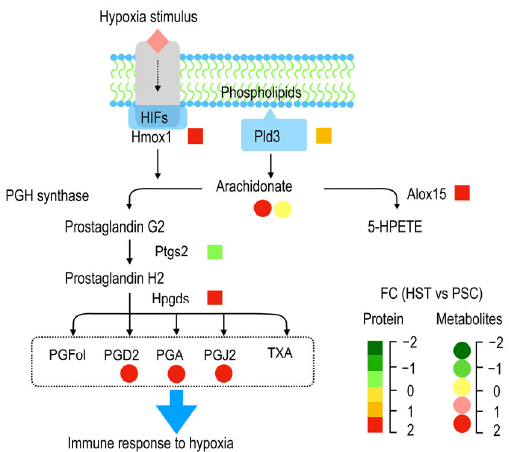
Figure 5. Schematic representation of the changes in metabolites and proteins involved in arachi ‐ donate acid metabolism during hypoxia response in spleen of mice. Names of PGFol, PGD2, PGA and PGJ2 were referred to Table S3. FC represents fold